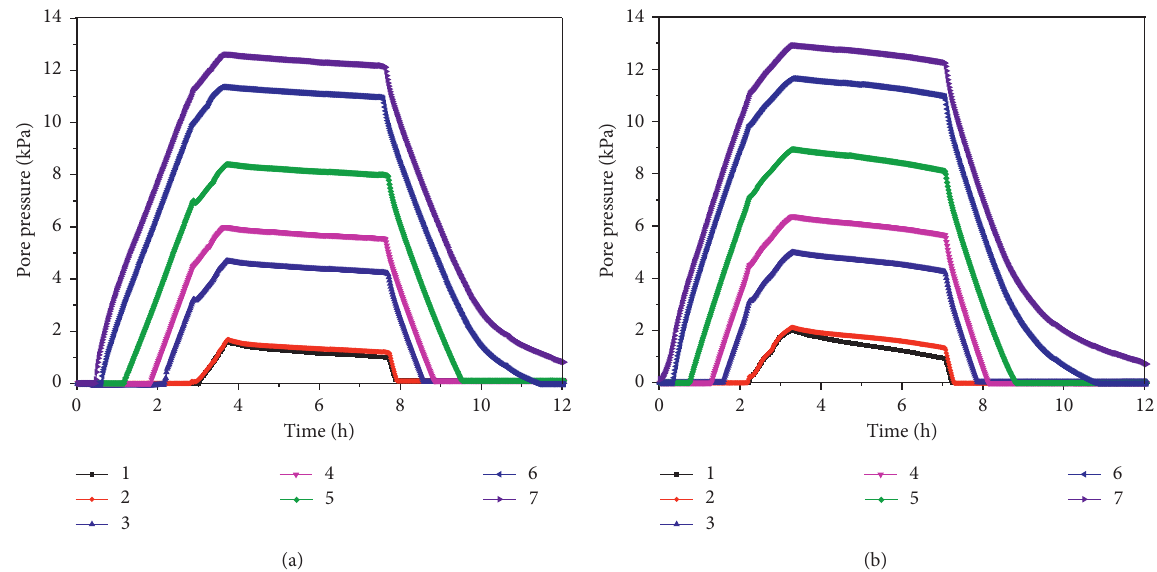
Figure 9: Variation of pore pressure with time. (a) Pile load: 12kN. (b) Pile load: 24kN.